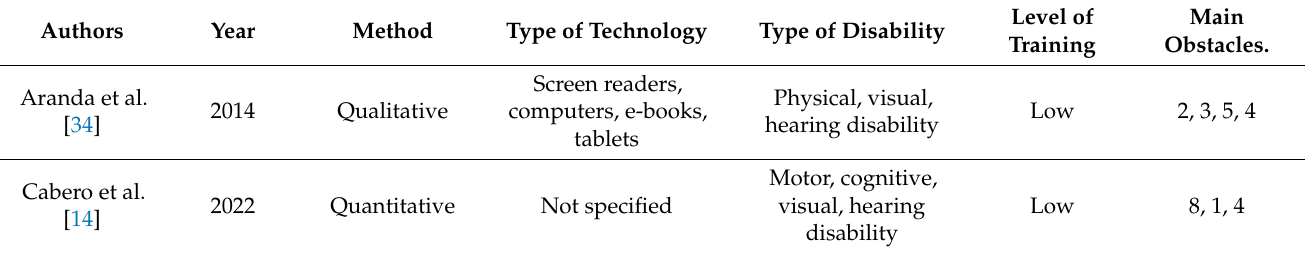
Table 1. Description of the studies included in the